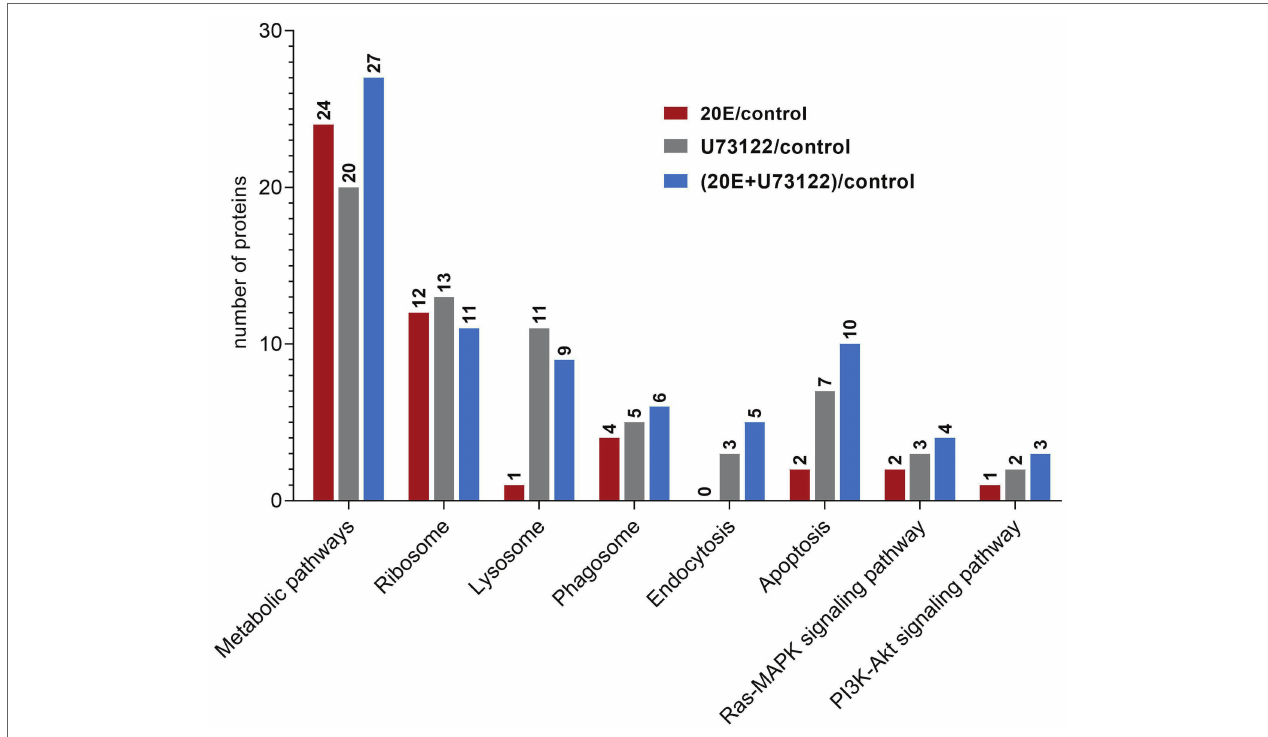
FIGURE 3 | Kyoto Encyclopedia of Genes and Genomes (KEGG) pathway analysis of DEPs identified after treatment of A. lucorum with 20E, U73122, and 20E + U73122.